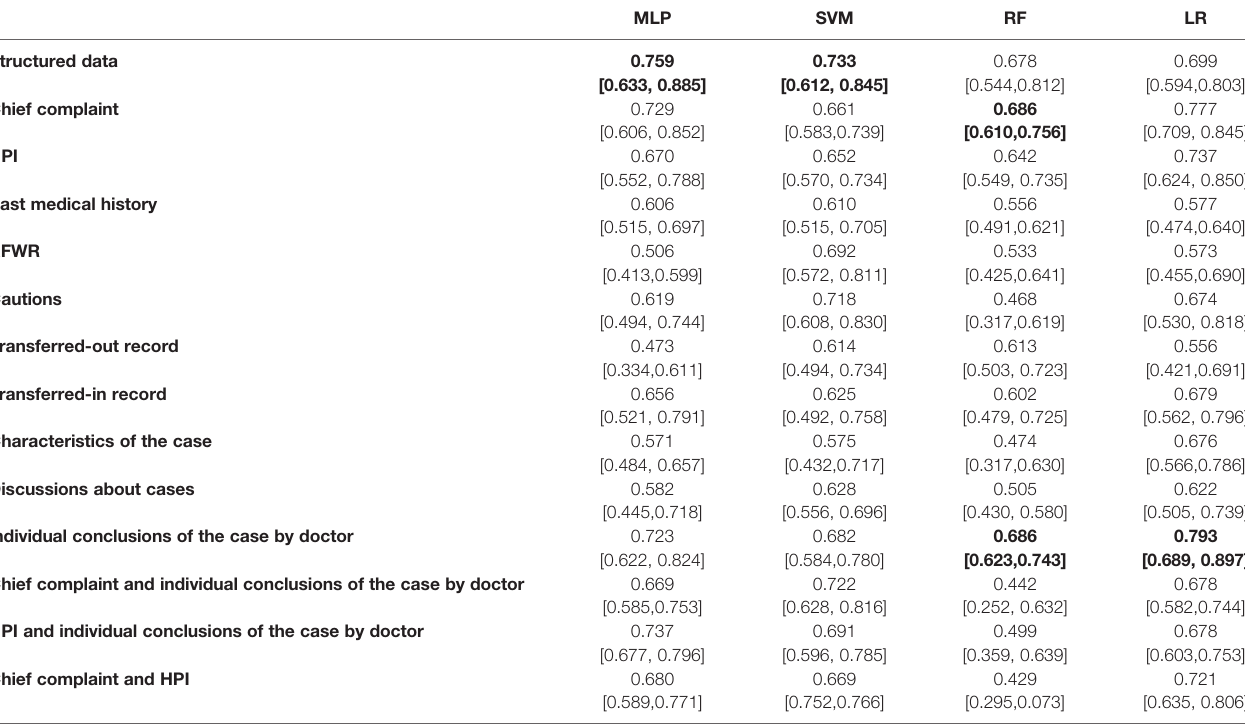
TABLE 4 | AUC values and 95 con fi dence interval of different models with different features.